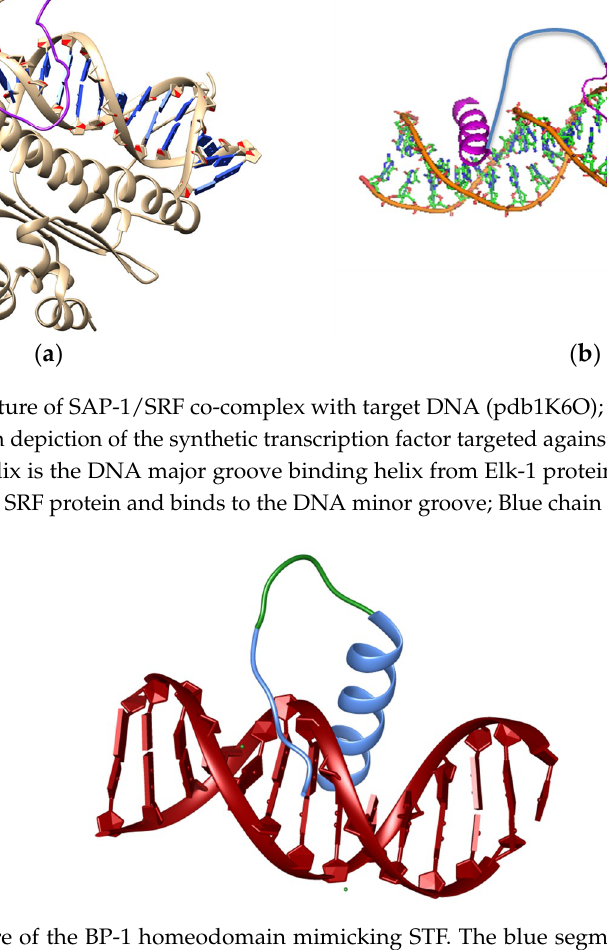
Figure 4. Structure of the BP-1 homeodomain mimicking STF. The blue segments of the STF were derived from the homeodomain and the green segment was the designed linker.